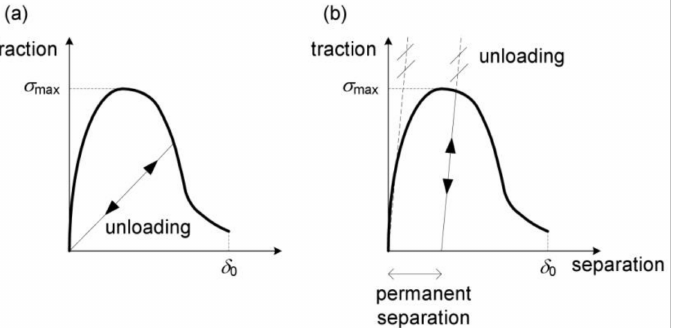
Figure 5. Methods of considering loading/unloading in cohesive models: ( a ) No permanent sep- aration after unloading, ( b ) model taking into account permanent (plastic) deformation, based on